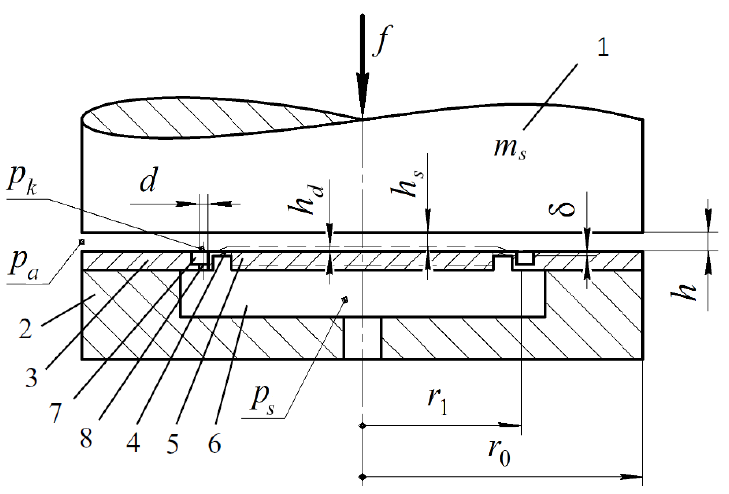
Figure 1. Calculation scheme of the bearing. Compared to a conventional support ( h d = 0), the volume of air contained in the bearing layer will be less due to deformation of h d , where the gap h s on the central circle will always be less than the gap h on the outer ring. In addition, due to deformation of the ring, 4, the vibration pattern of the bearing layer will change, which can also contribute to an increase in the dynamic quality of the bearing. This paper considers a mathematical model of the stationary state of the bearing and calculates its optimal modes. On this basis, non-stationary mathematical modeling of the effectiveness of the proposed method for improving the dynamic characteristics and the calculation and study of the root stability criteria of the bearing were carried out. An example of the design calculation of the bearing is